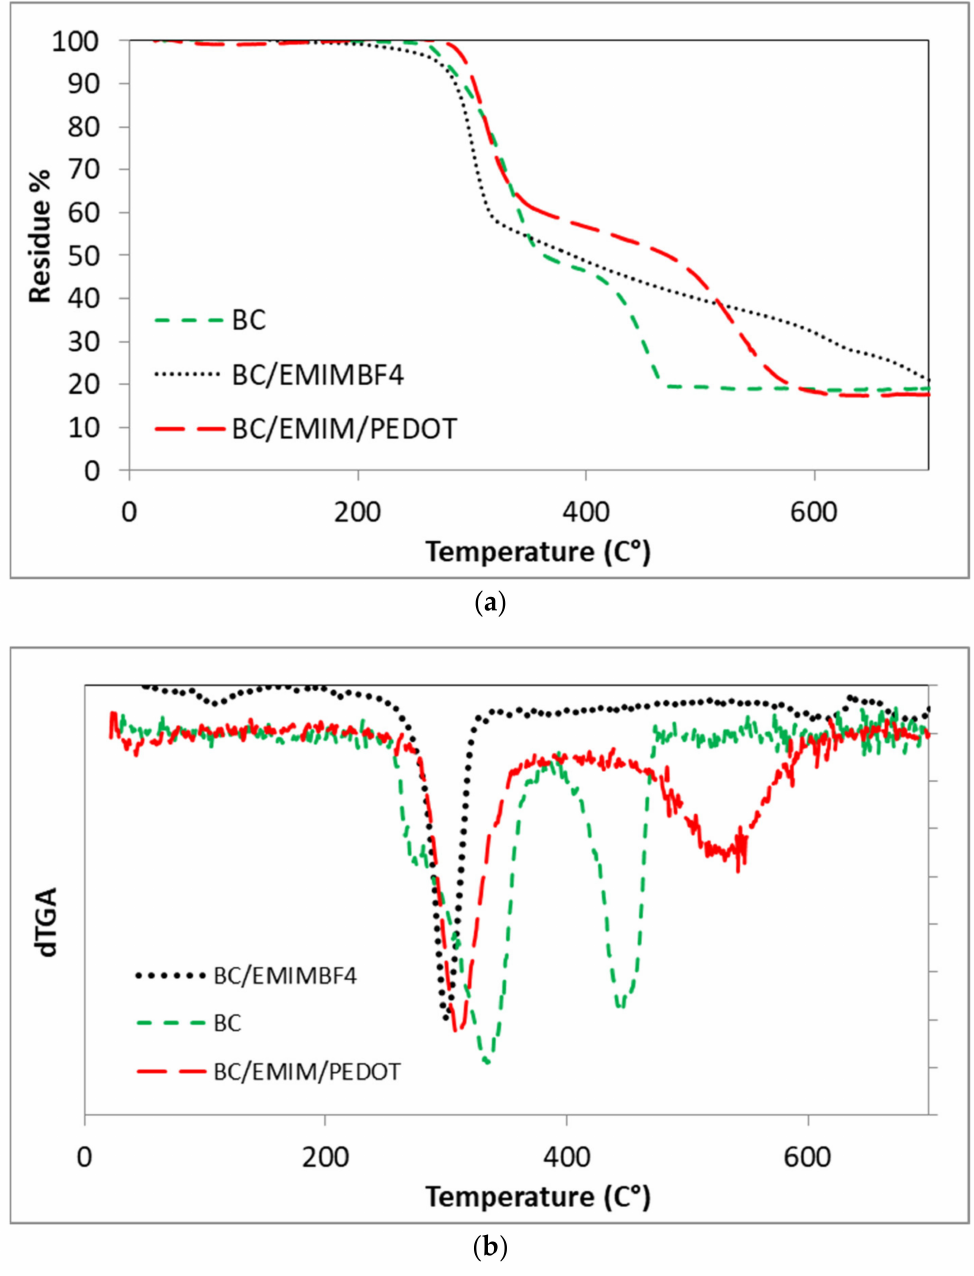
Figure 5. TGA ( a ) and dTGA ( b ) of samples BC, BC/EMIMBF4, and BC/EMIM/PEDOT (© [2021] IEEE. Reprinted, with permission, from